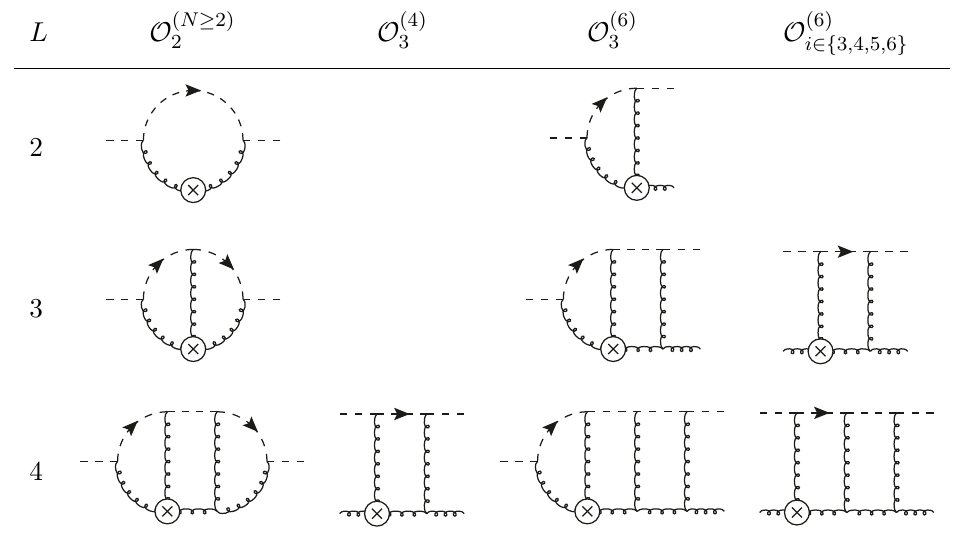
i in the background field 11